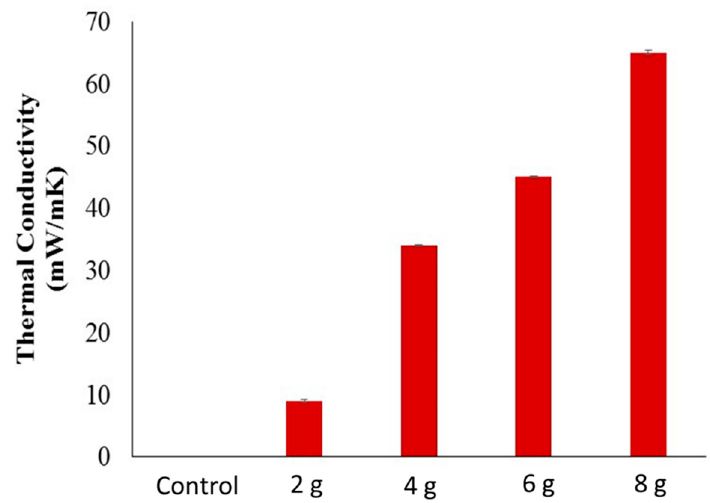
Figure 17. Thermal conductivity of developed composite samples .